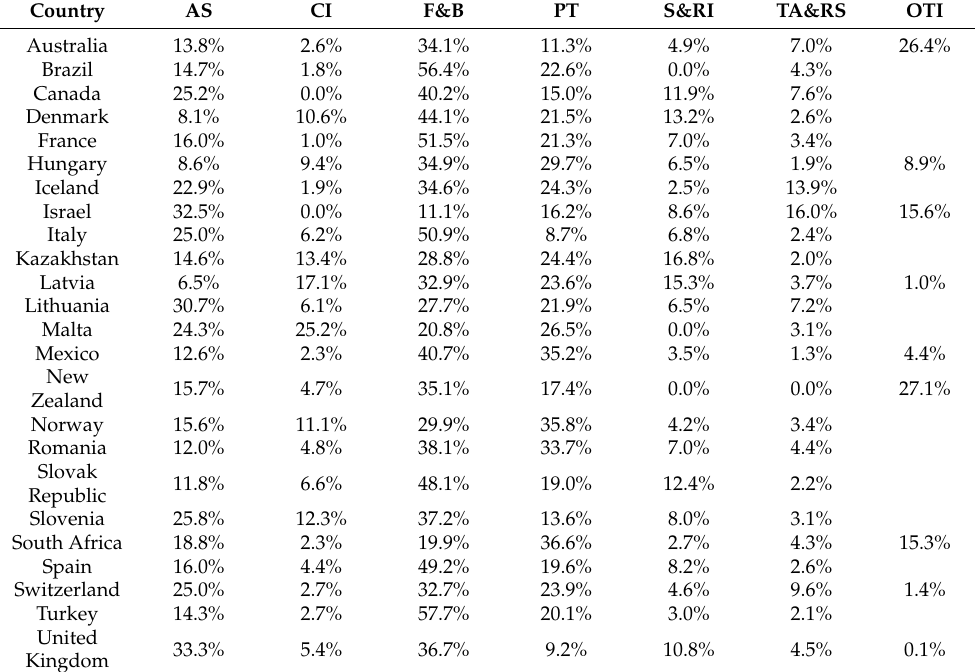
Table A1. Percentage distribution by tourism industries of the total employment in the tourist sector in 2017. Countries in alphabetical order. Source: OECD data for 2017.